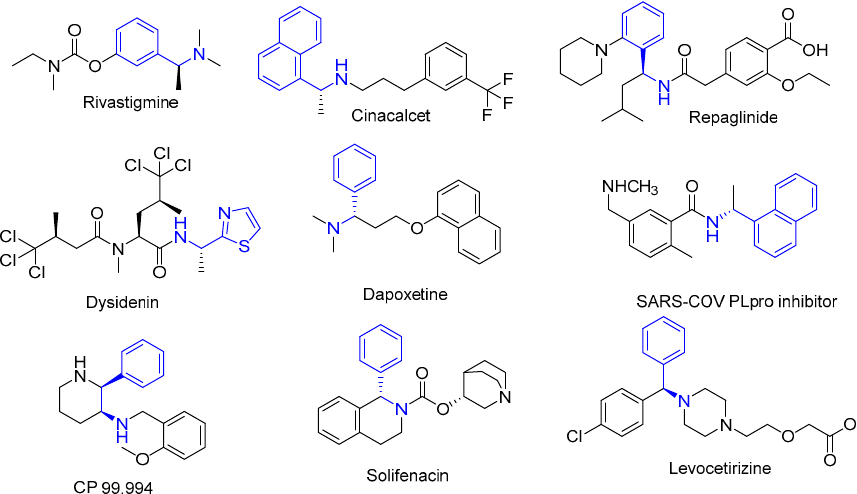
Figure 1. Biologically important compounds containing chiral aromatic amines.